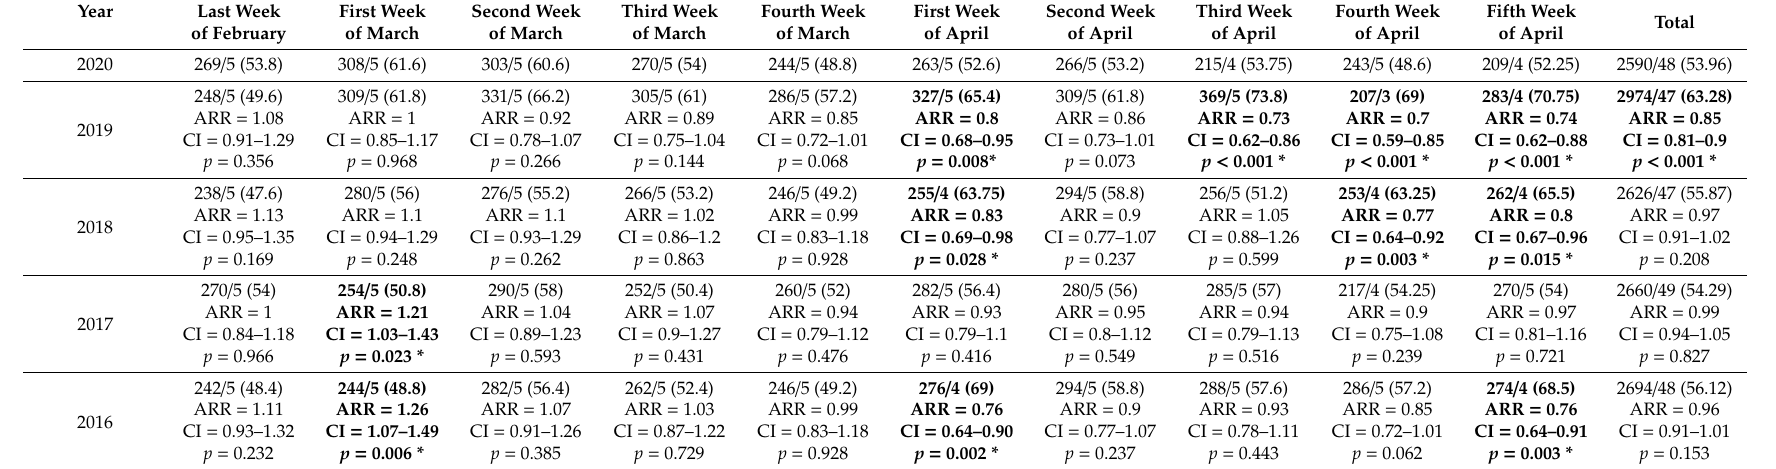
Table 1. Number of patient accesses and access rates for 2020, 2019, 2018, 2017, and 2016 in each considered